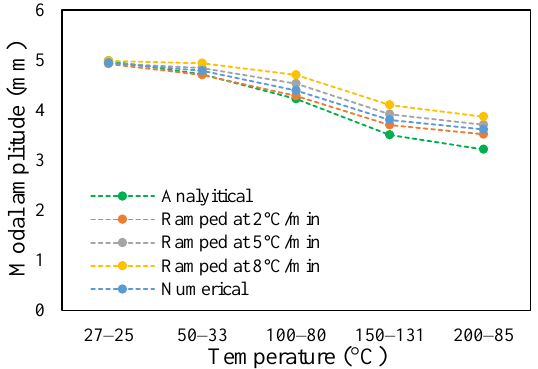
Figure 16. Modal amplitude of 0.25 mm crack depth in non-uniform temperature.